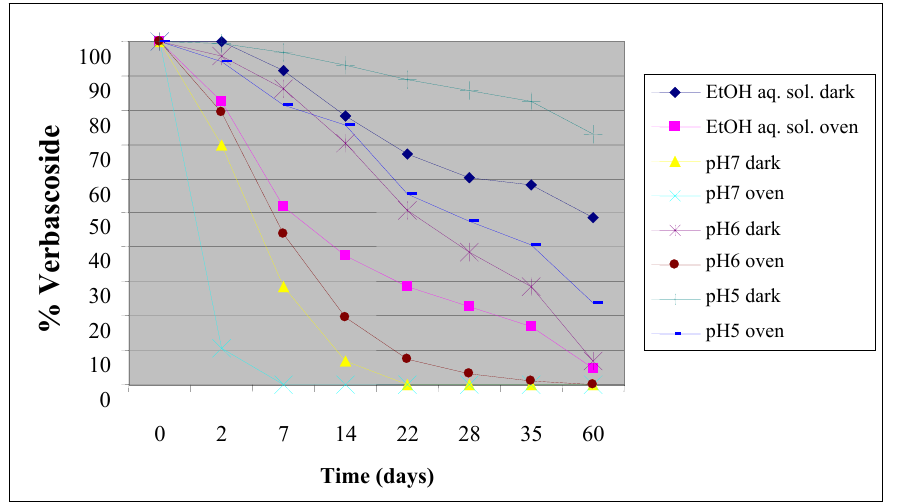
Figure 2. Verbascoside stability in solution at different pH value and storage